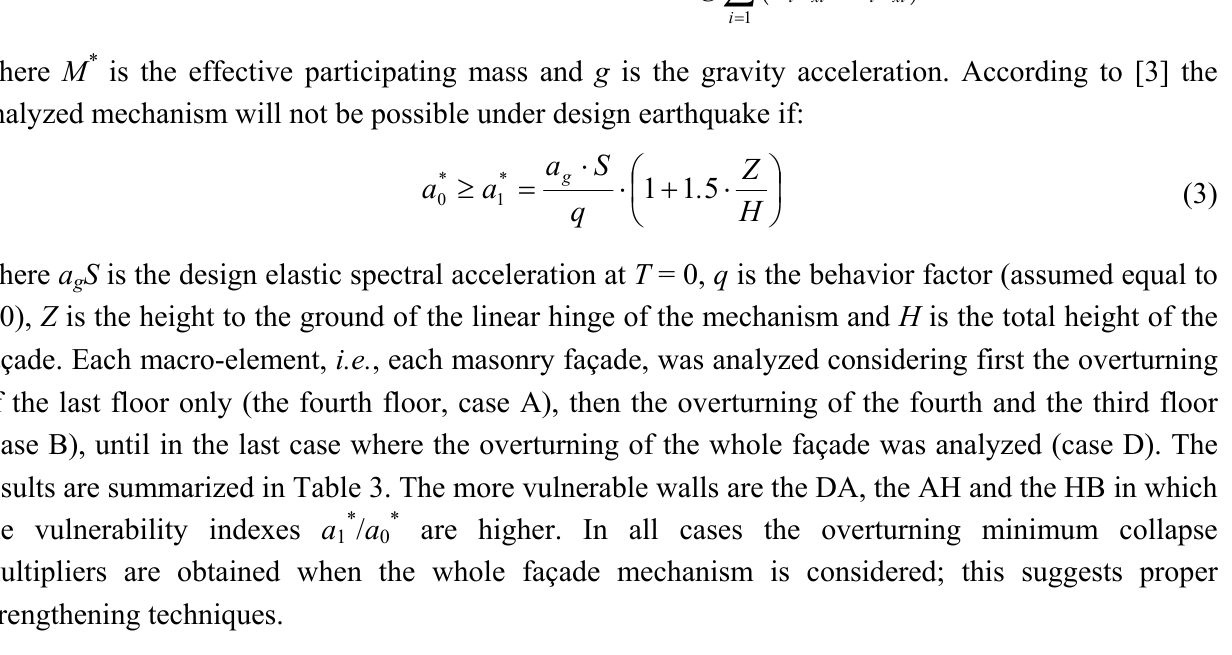
= collapse multipliers; 0 ; a 1* = seismic spectral accelerations 0